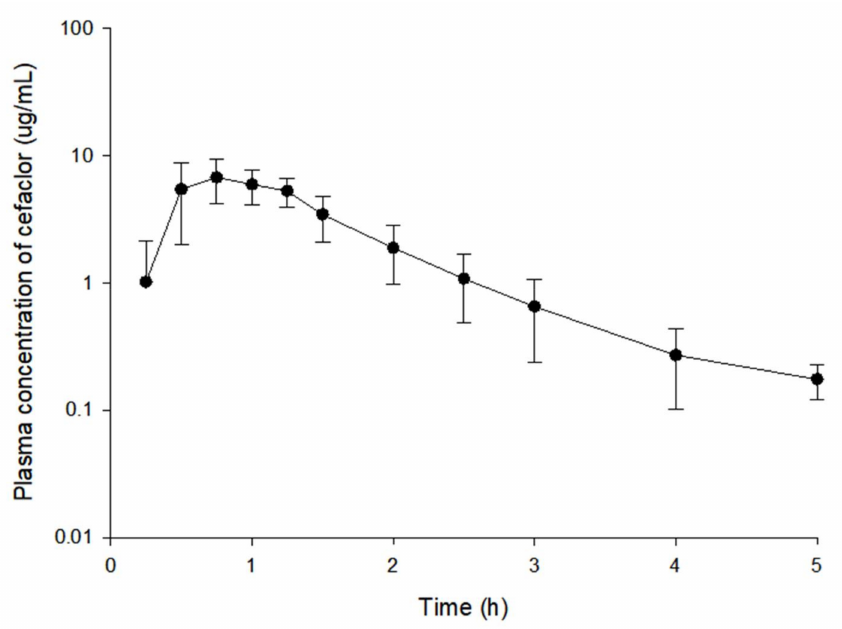
Figure 1. Log-transformed mean plasma concentration–time profiles of cefaclor. Vertical bars represent standard deviation of the mean ( n =